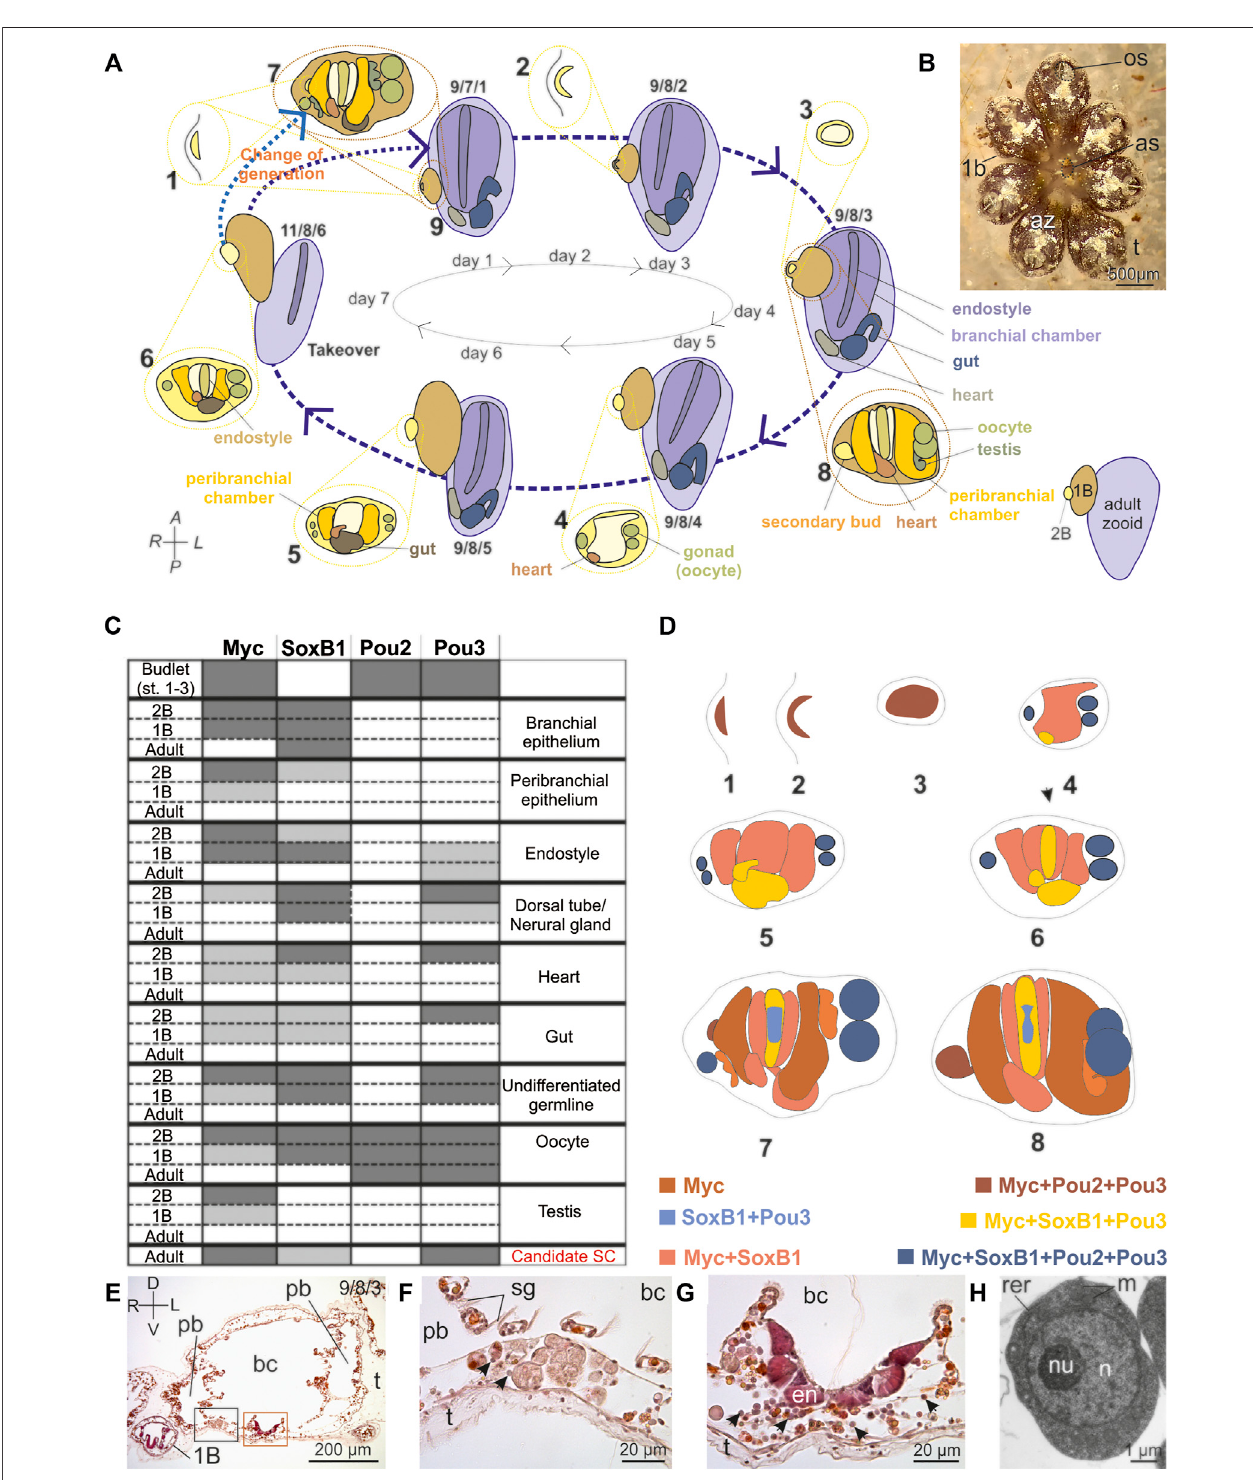
FIGURE 1 | Botryllus schlosseri blastogenic cycle and Yamanaka Factors spatio-temporal expression pattern. (A) The weekly blastogenic cycle (dashed blue arrows)beginswhena2Bemergesasathickeningoftheparentalperibranchial chamberepitheliumaccompaniedbytheepidermis(stage1).The2Bthenarches(stage 2) before it closes (stage 3) in a “ double vesicle ” : the outer vesicle is formed by the epidermis, the inner one by the original peribranchial epithelium. The inner vesicle undergoes invaginations (stage 4) to form the branchial and peribranchial chamber rudiments. In the lateral mesenchymal space between the inner and the outer vesicle germ cells reside whereas the heart rudiment forms postero-ventrally. The branchial chamber rudiment forms posteriorly the gut rudiment (stage 5), whereas on